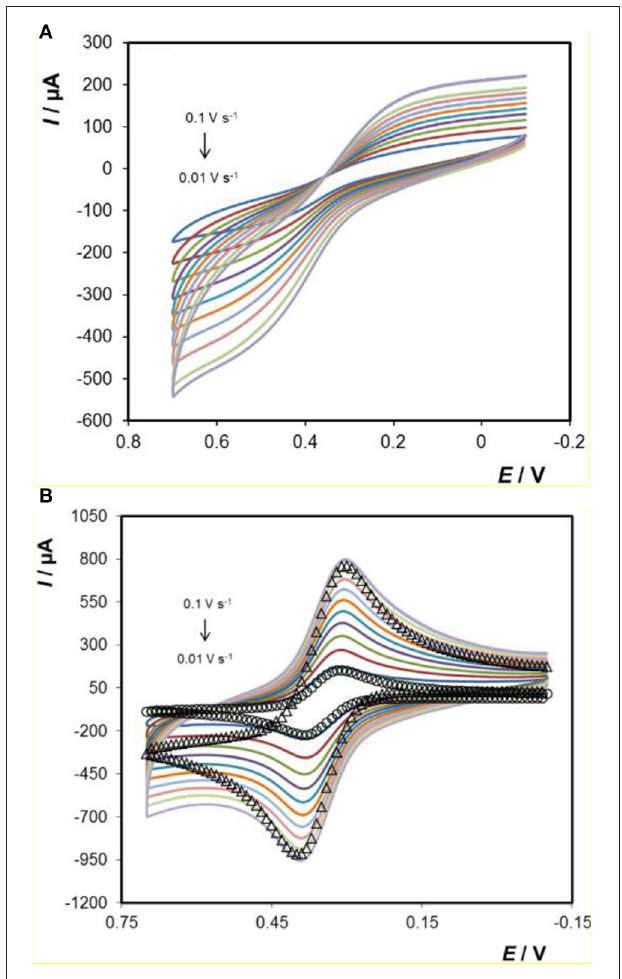
FIGURE 6 | Voltammograms of (A) 3D Ti electrode and (B) Au-coated 3D Ti electrode in 1mM ferrocyanide in 0.1M H 2 SO 4 as supporting electrolyte. From smallest to largest peak currents, the scan rates are 0.01, 0.02, 0.03, 0.04, 0.05, 0.06, 0.07, 0.08, 0.09, and 0.1V s − 1 . The open circles ( ◦ ) represent the best fit under semi-infinite linear diffusion control where the standard rate of heterogeneous electron transfer, k o , is 8 ± 0.4 × 10 − 3 cm s − 1 . The open triangles ( 1 ) represent the predicted response at 0.1V s − 1 but where the currents have been multiplied by a factor of